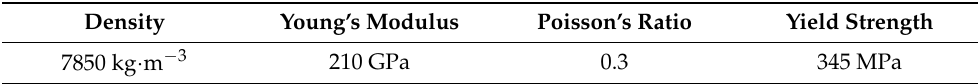
Table 1. Material properties of Q345B steel.